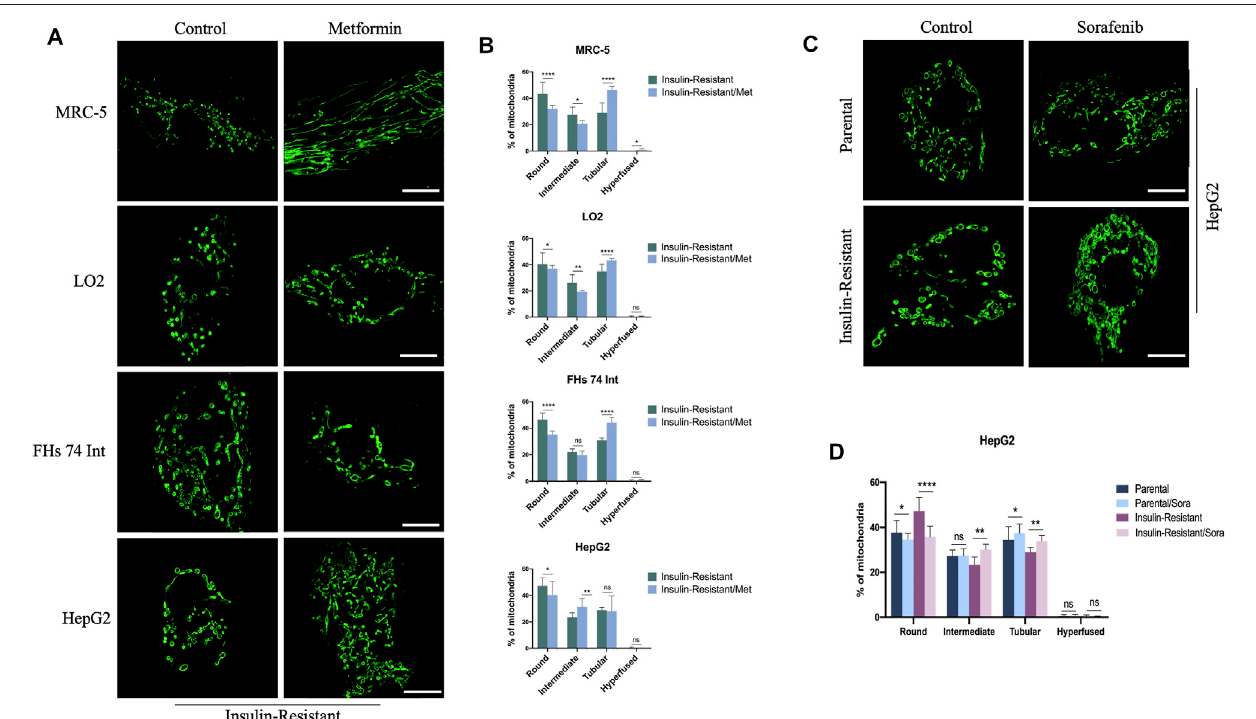
FIGURE 2 | Effect of metformin or sorafenib on mitochondrial morphology in IR cells. (A) Representative images of mitochondrial morphology in IR MRC-5, LO2, FHs 74 Int, and HepG2 cells treated or untreated with metformin. (B) Quantitative analysis for the four morphological groups (round, intermediate, tubular, and hyper- fused)inIRMRC-5,LO2, FHs 74Int,and HepG2 cells treatedor untreated with metformin. (C) Representative images ofmitochondrial morphology inIRHepG2 cancer cells with or without sorafenib treatment. (D) Quantitative analysis for the four morphological groups (round, intermediate, tubular, and hyper-fused) in IR HepG2 cancercells with orwithout sorafenib treatment, respectively. Scale bar: 10 μ m. Data showed asmean± SD. * p < 0.05, ** p < 0.01, *** p < 0.001, and **** p < 0.0001,ns: no signi fi